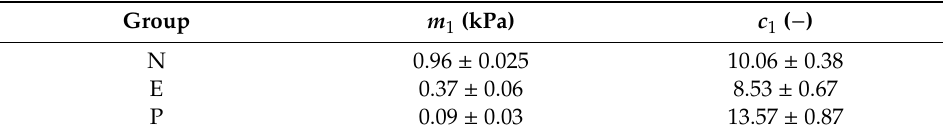
Table 3. Wall stress (mean ± SEM) computed in the mid-section of the FEA geometries corresponding to the three Ogden material models.